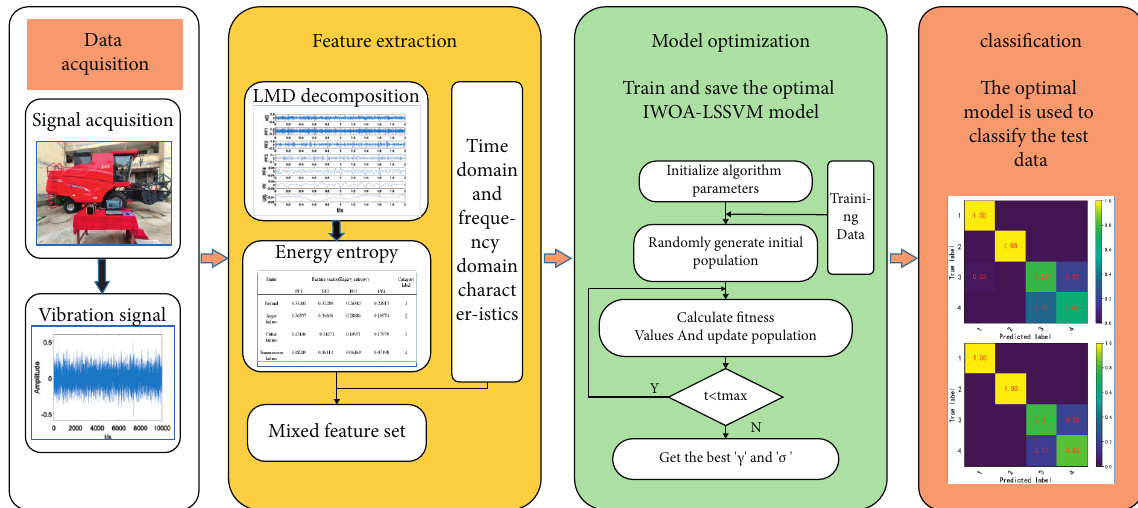
Figure 2: The flow chart of assembly quality